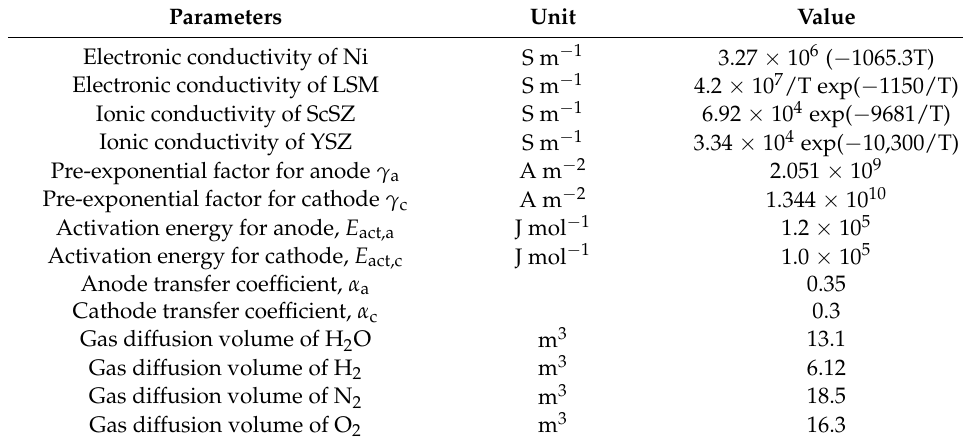
Table 3. Modeling parameters [39,40].